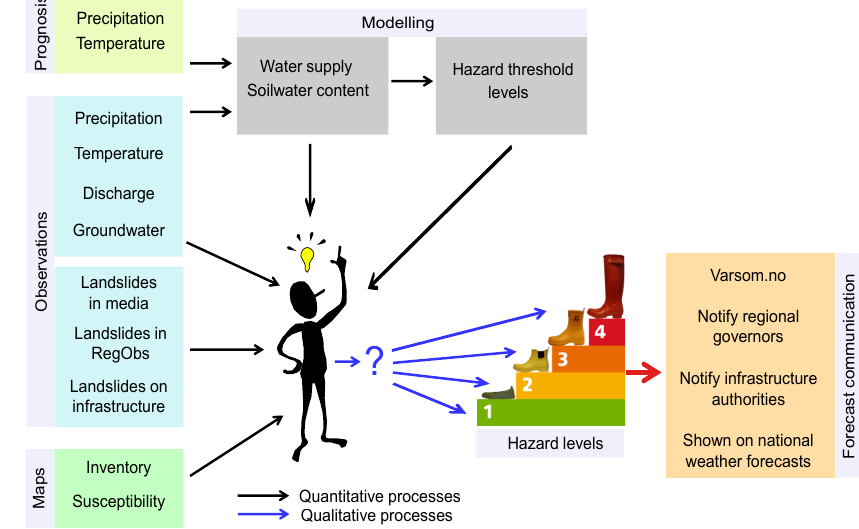
Figure 1. Organization of the landslide early warning system in Norway.